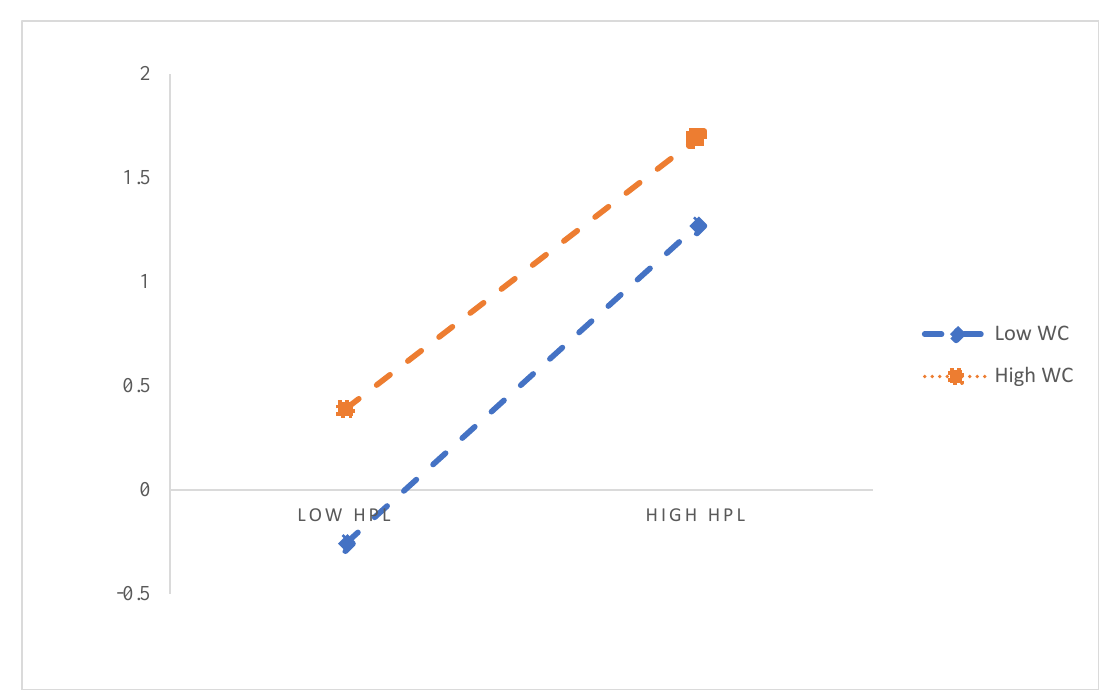
Figure 2. The moderating role of WC in the relationship between HPL and Ey.